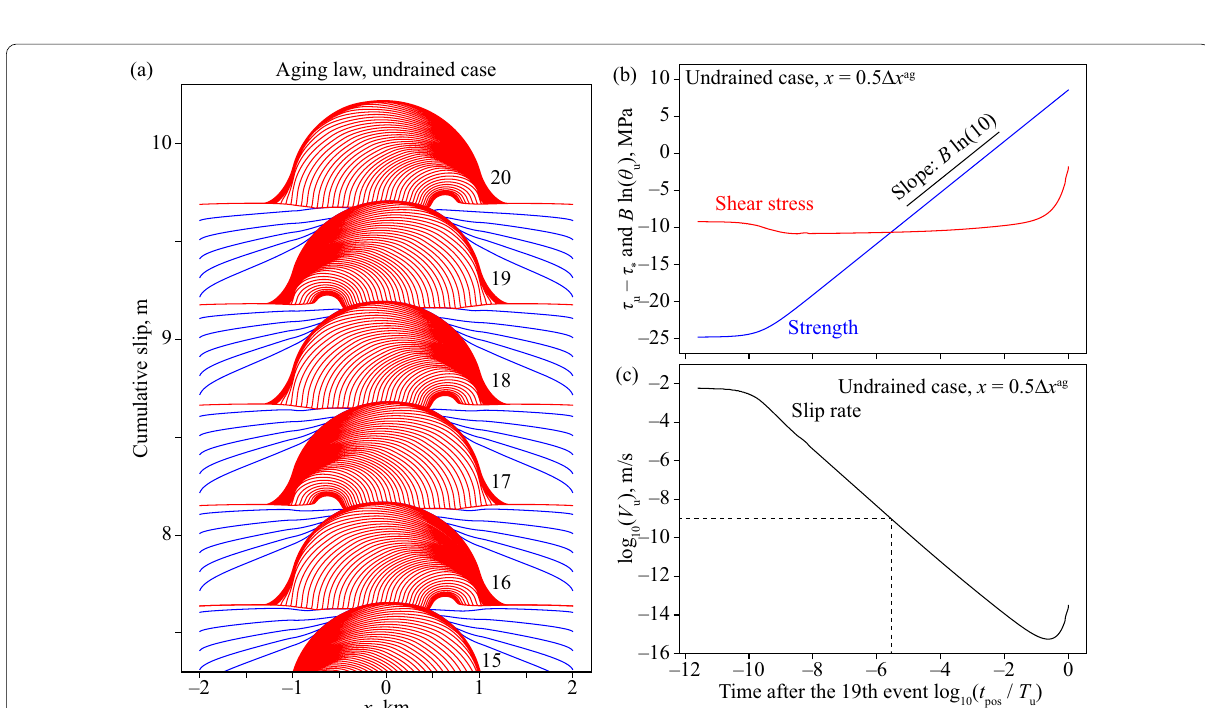
Fig. 5 Simulation result in the undrained case with the aging law. For presentational purposes, the length scale is selected as R = 1km . a Cumulative slip distribution, blue: every 10 8 s , red: every 0.02s during earthquakes. Integers indicate ordinal numbers of earthquakes in the simulated sequence. b Shear stress (red) and strength (bule) of the fault relative to the reference at x = 0.5 � x ag = R / 256 as a function of time after the 19th earthquake. c Slip rate near the center, x = 0.5 (cid:31) x ag as a function of time after the 19th